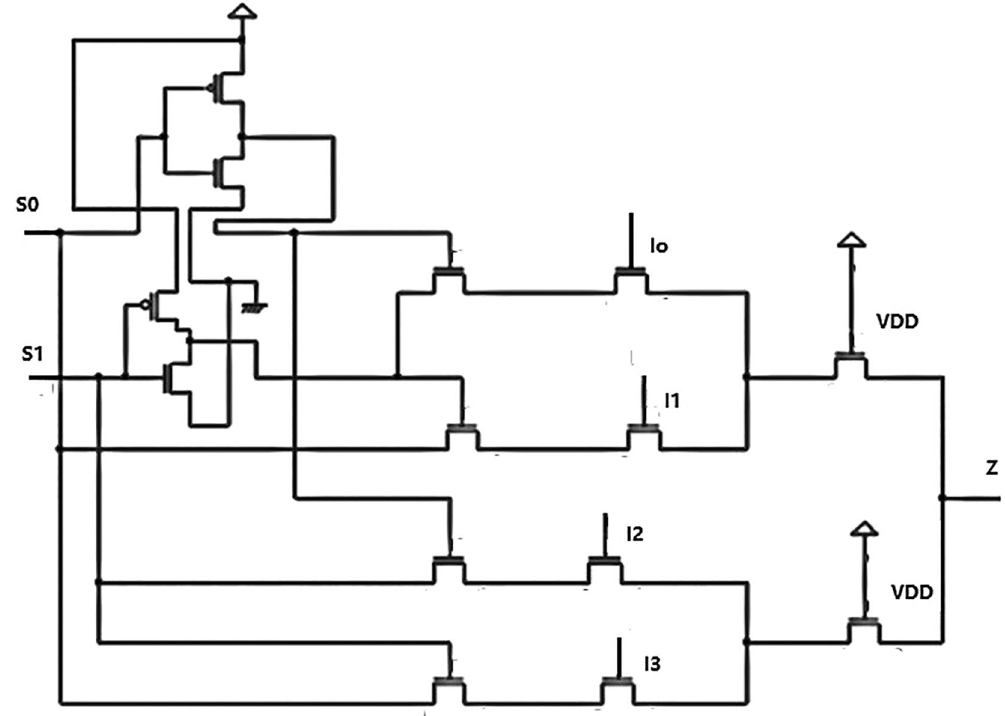
Figure 1. Proposed circuit of the 4 (cid:1) 1